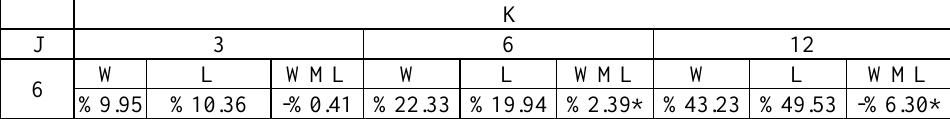
Table (1) MomentumStrategies’